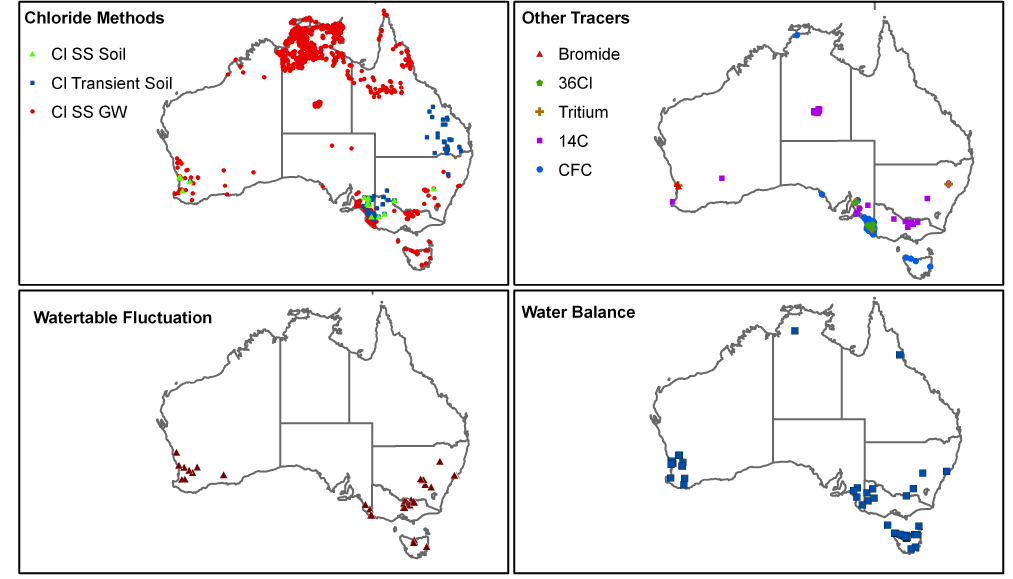
Fig. 3. Locations of studies where the different methods have been used to estimate